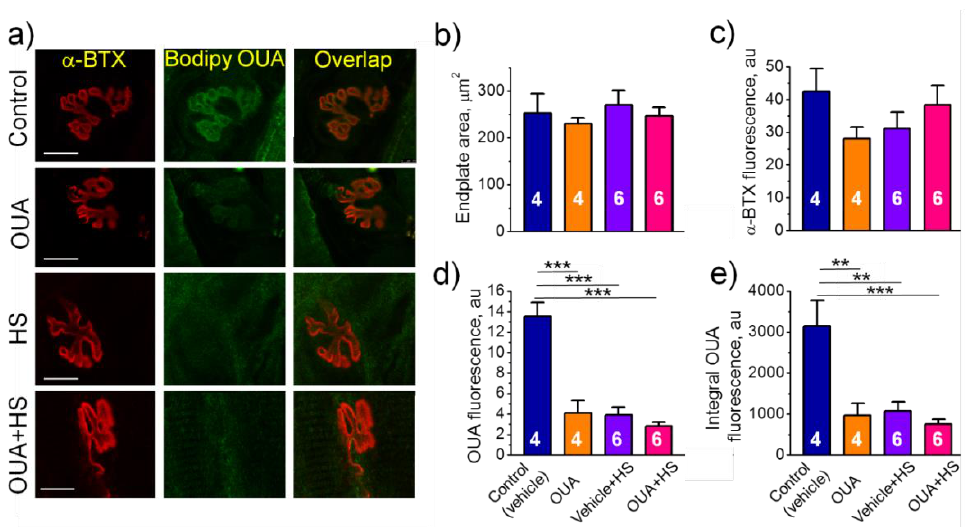
Figure 4. Characteristics of the α 2 Na,K-ATPase localization in the rat soleus muscles. ( a ) Representative images of endplates dual-labeled with α -BTX (nAChRs, red channel) and BODIPY-conjugated ouabain ( α 2 Na,K-ATPase, green channel). Overlap—orange. Scale bars—10 µ m. ( b , c ) Averaged area of endplates and fluorescence intensity (arbitrary units) from the nAChR staining, respectively. ( d , e ) Averaged fluorescence intensity and integral intensity over the entire area of endplates from the α 2 Na,K-ATPase staining (arbitrary units). Control and ouabain-treated (OUA) groups are